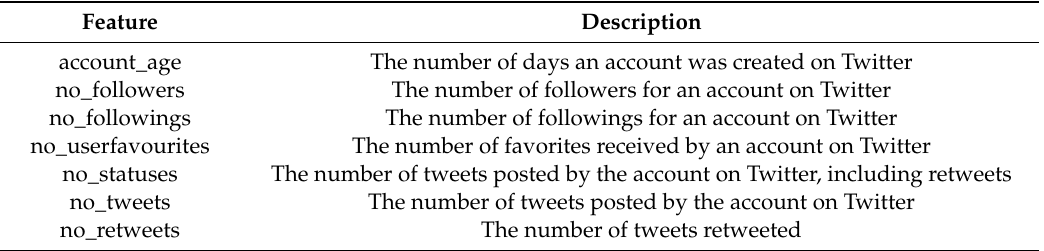
Table 1. Feature